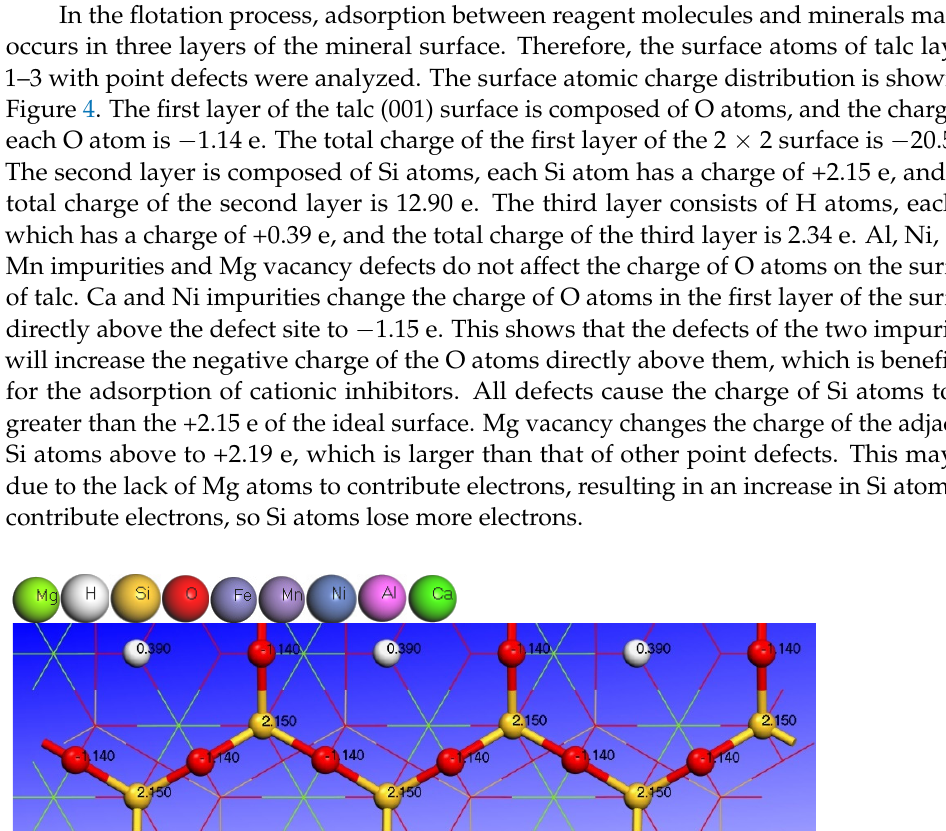
Figure 3. Top view of the (2 × 2 × 1) supercrystal cell on talc (001) surface under ideal condition.